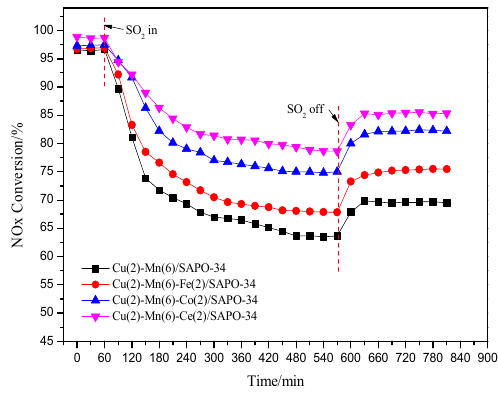
Figure 3. Changes of anti-SO 2 performance of Cu–Mn/SAPO-34 catalyst after modification of different transition metal additives.